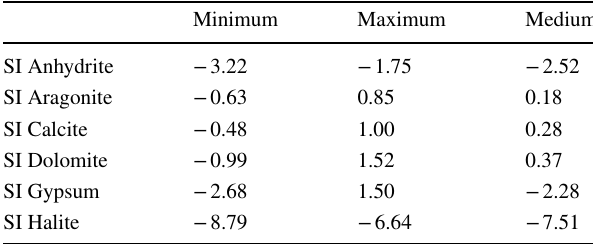
Table 2 Average values of calculated parameters